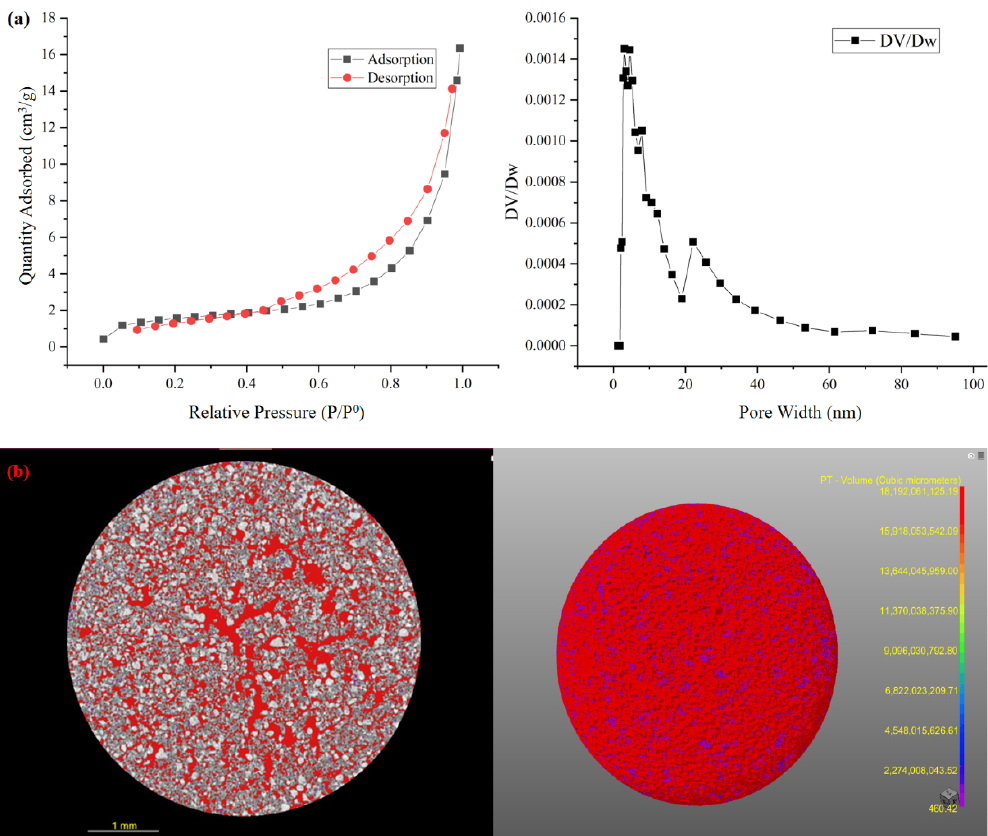
Figure 3. Pore structure characterization of RSC: ( a ) The N 2 adsorption/desorption isotherms of SRC and the pore size distribution, and ( b ) CT.